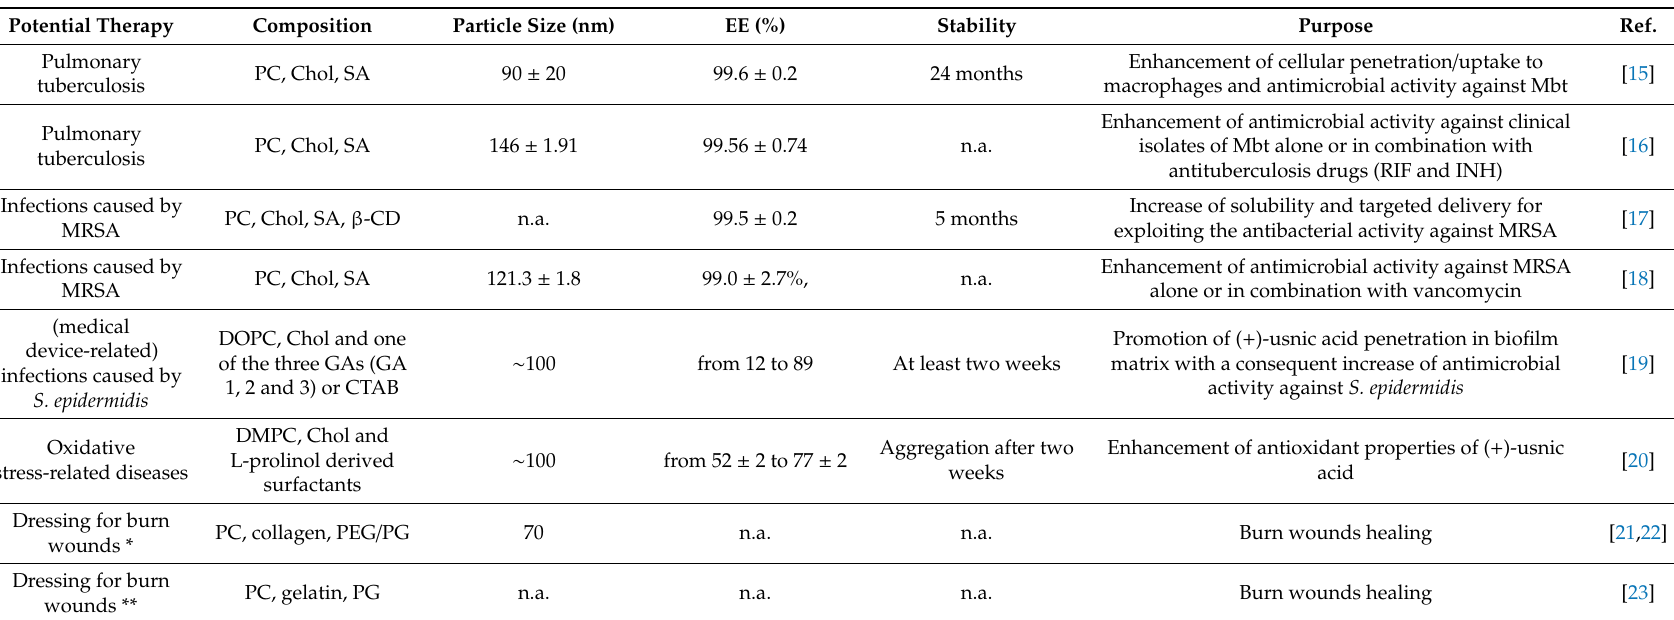
Table 2. List of the investigated usnic acid-loaded